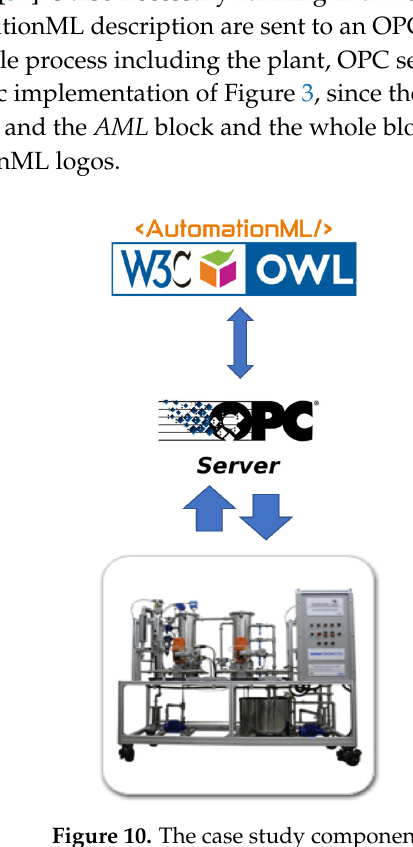
Figure 10. The case study